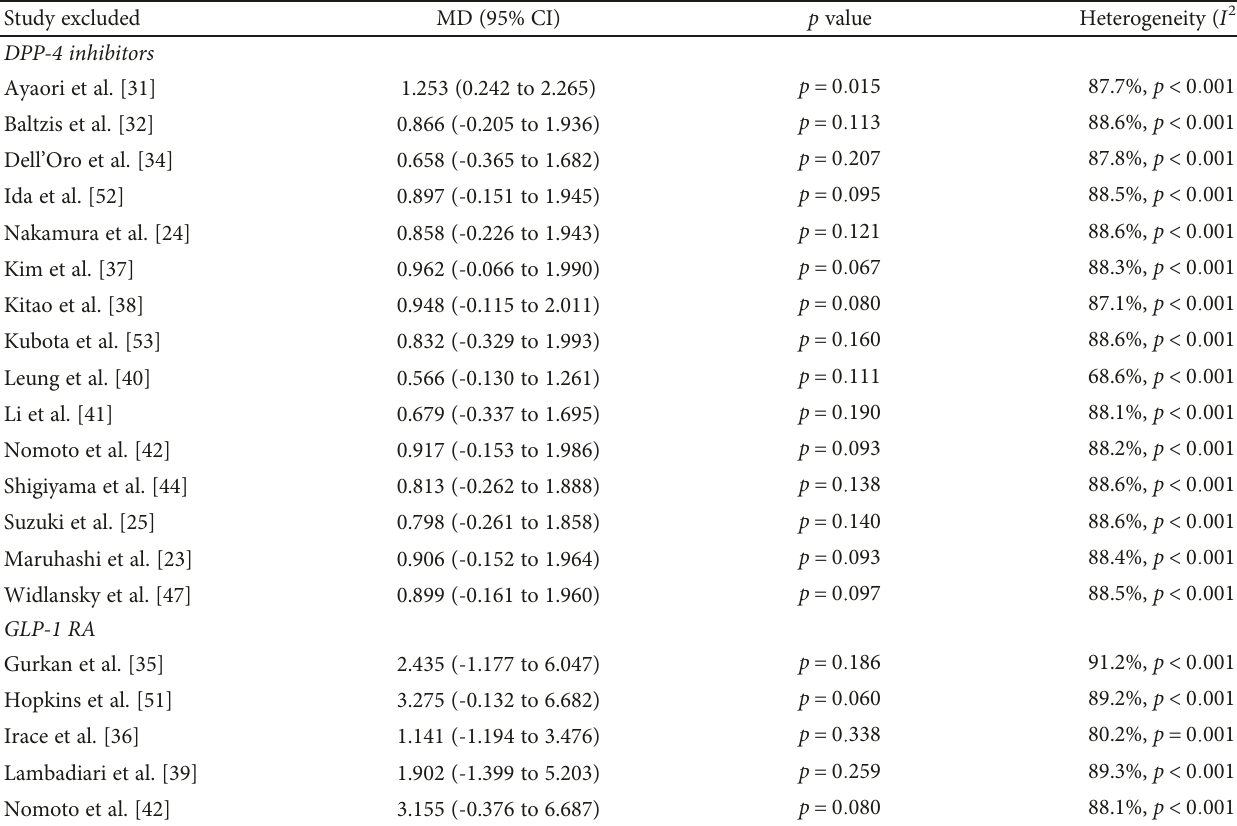
Table 2: Leave-one-out sensitivity analysis for the e ff ects of newer antidiabetics on endothelial